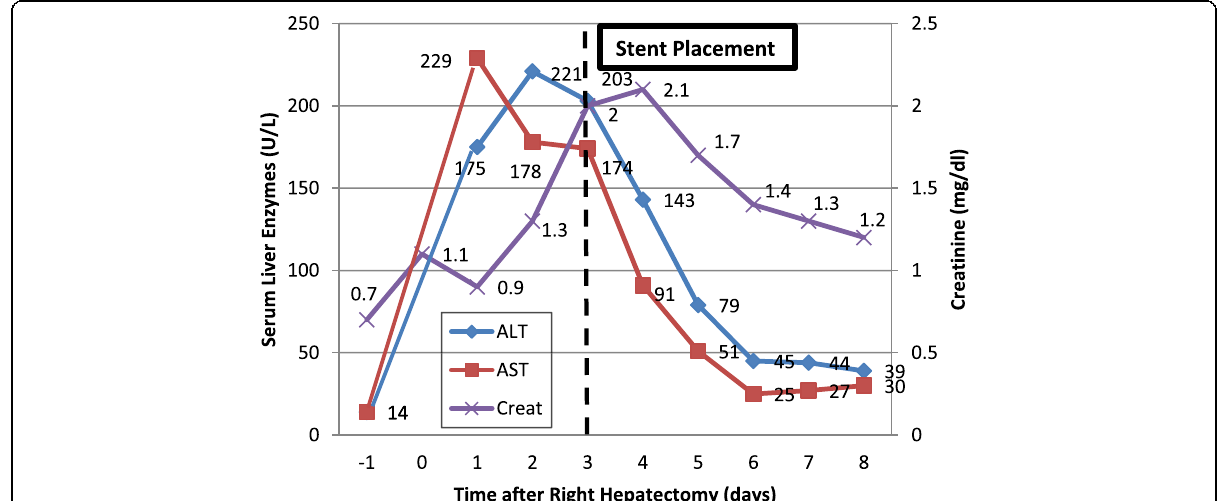
Fig. 3 Peri-operative laboratory data. Gradual elevation of the liver enzymes and creatinine levels were observed following right hepatectomy with resolution folllowing IVC stent